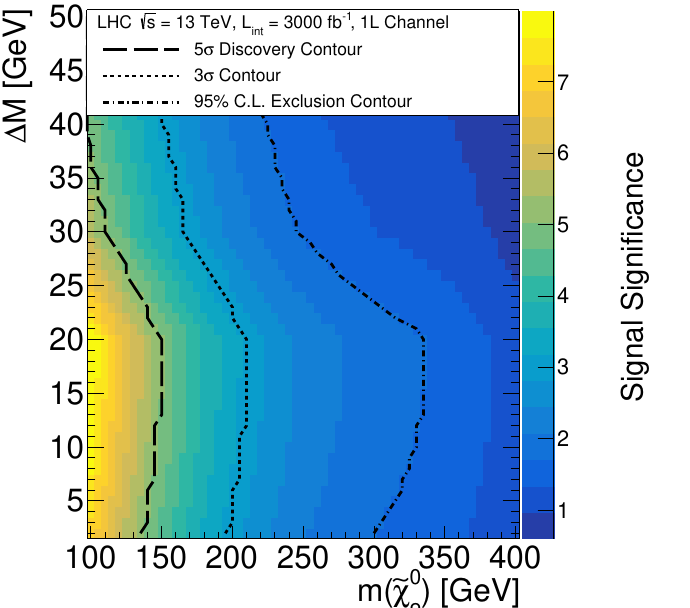
Figure 10 . Combined signal significance for the single lepton final states as function of ˜ χ 0 for different integrated luminosity